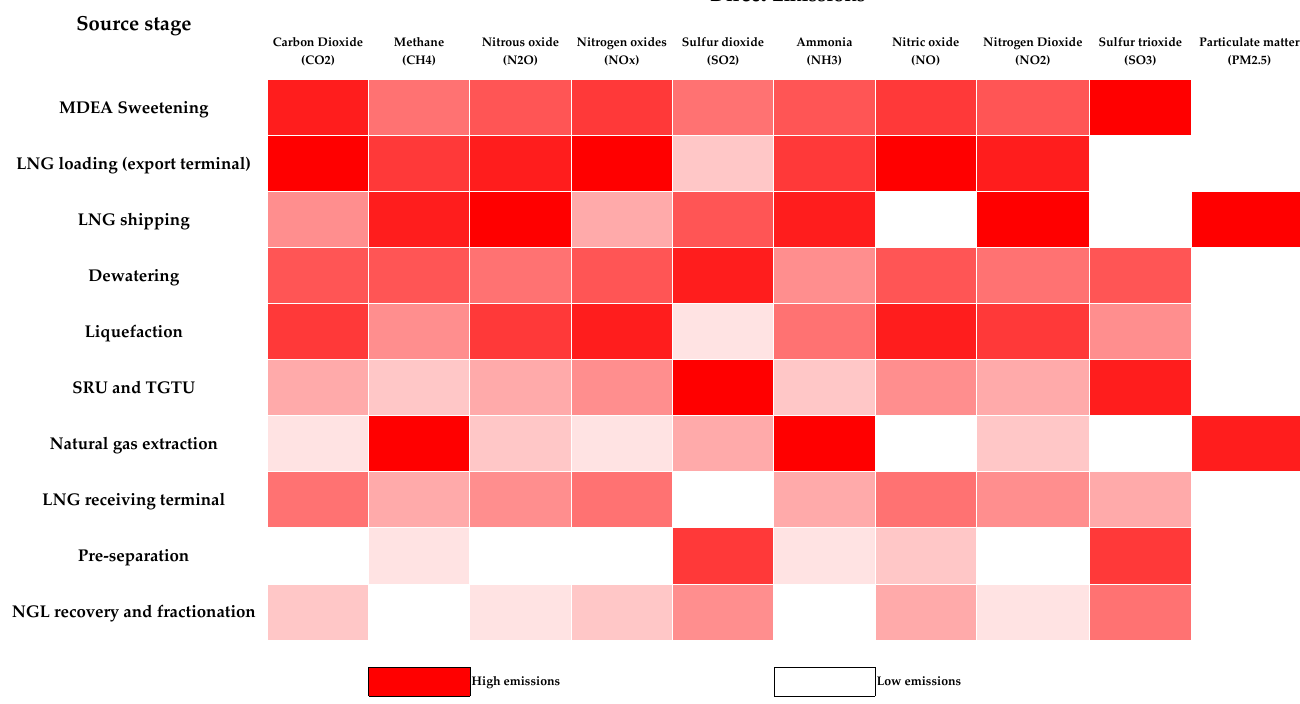
Figure 14. Heat map diagram for air pollutants from several process units in LNG manufacturing and supply chain.